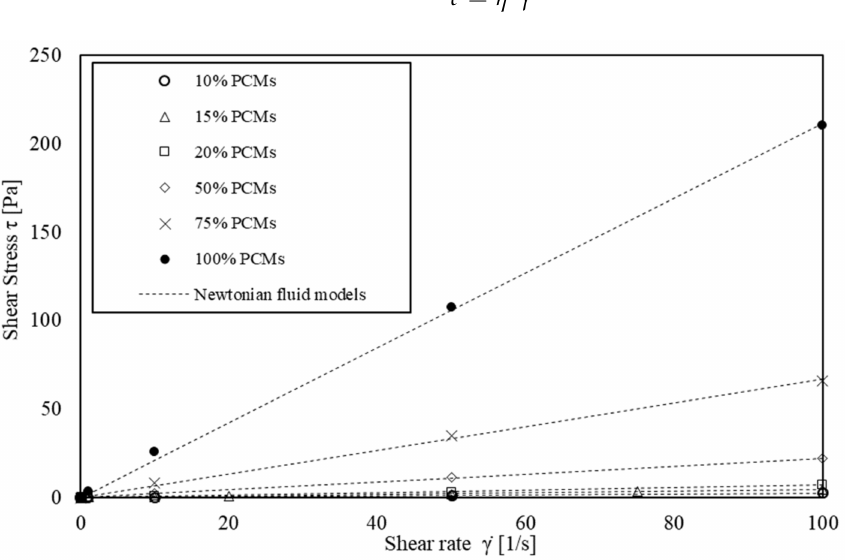
Figure 5. Shear flow curves of the interstitial fluid: PCMs in water. With τ , the shear stress (Pa); η , the viscosity (Pa · s) and best-fitting allows for modelling the experimental data with correlation coefficients higher than 0.99 (Figure